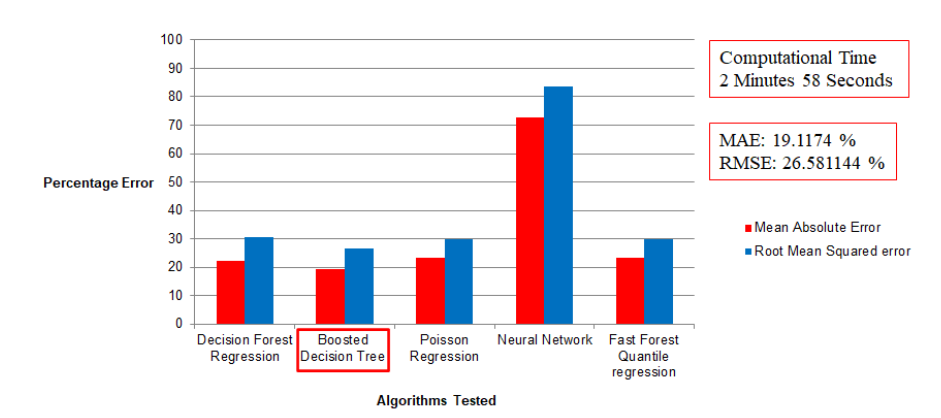
Figure 6. Regression model results for half